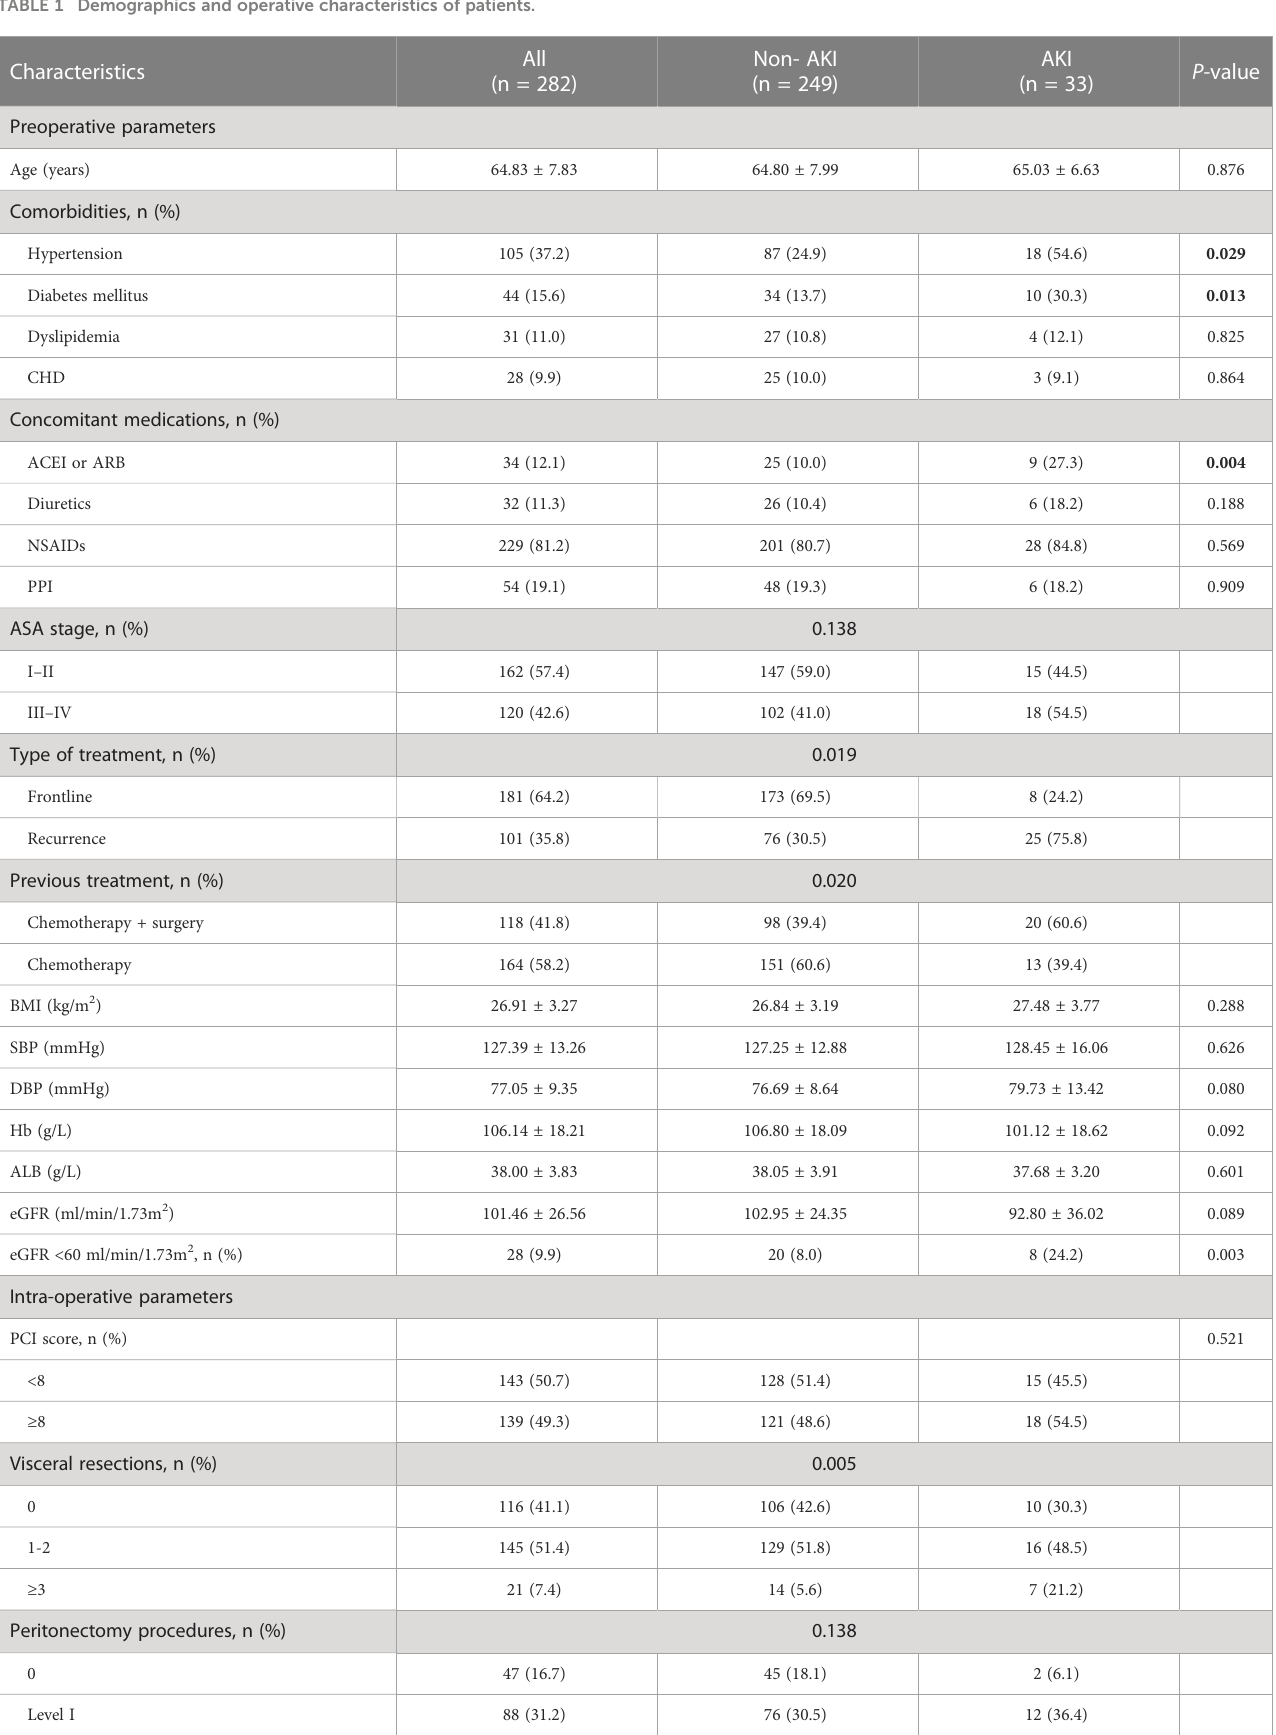
TABLE 1 Demographics and operative characteristics of patients.